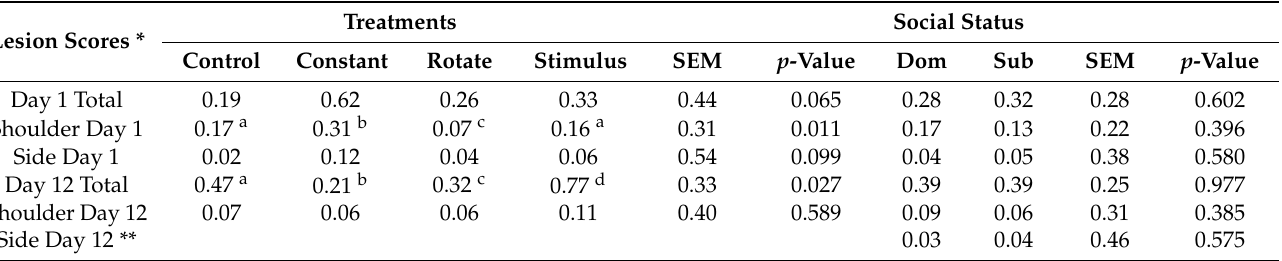
Table 7. Effects of enrichment treatments and social status on skin lesion scores in focal sows. Lesion scores were measured on treatment days 1 and 12.